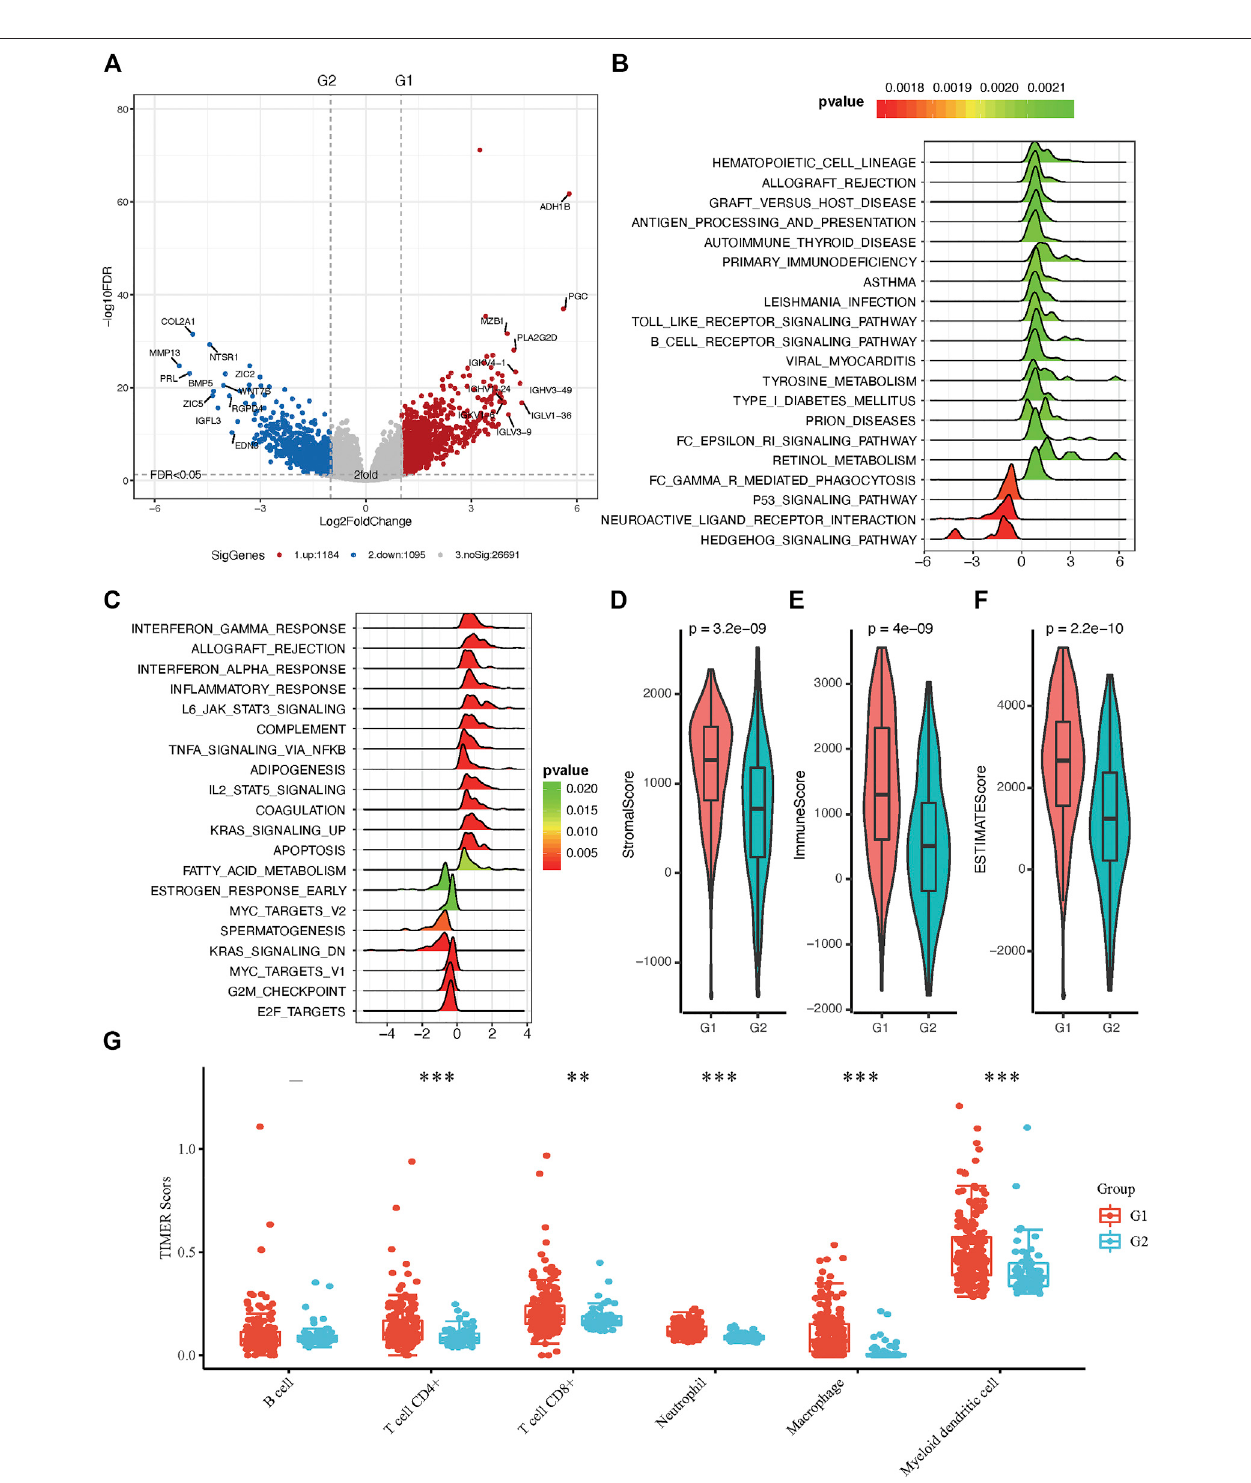
FIGURE 3 | Molecular and immunity features of the two subgroups. (A) Volcano plot of identi fi ed DEGs. (B) Functional annotation of the DEGs with hallmark pathways. (C) FunctionalannotationoftheDEGswithKEGGpathways (D – F) Theimmunemicroenvironmentbetweenthetwogroups. (G) DistributionofTIMER scores insarcomatissues,thehorizontalaxisrepresentsdifferentgroupsofsamples,theverticalaxisrepresentsgeneexpressiondistribution,differentcolorsrepresentdifferent groups, upper left corner represents signi fi cance p -value test method. Asterisks represent signi fi cance levels (* p < 0.05, ** p < 0.01, *** p < 0.001).